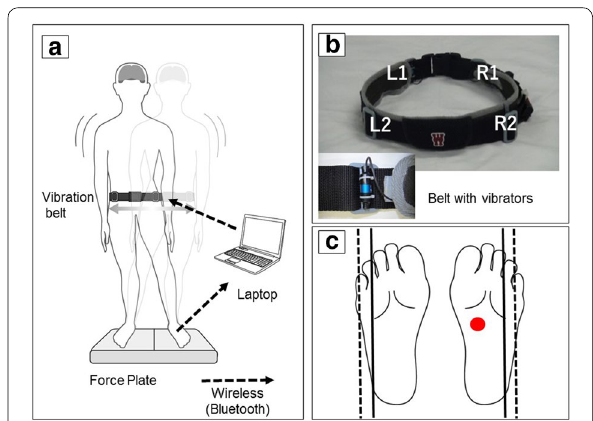
Fig. 3 Overview of the weight-shifting task and the vibration